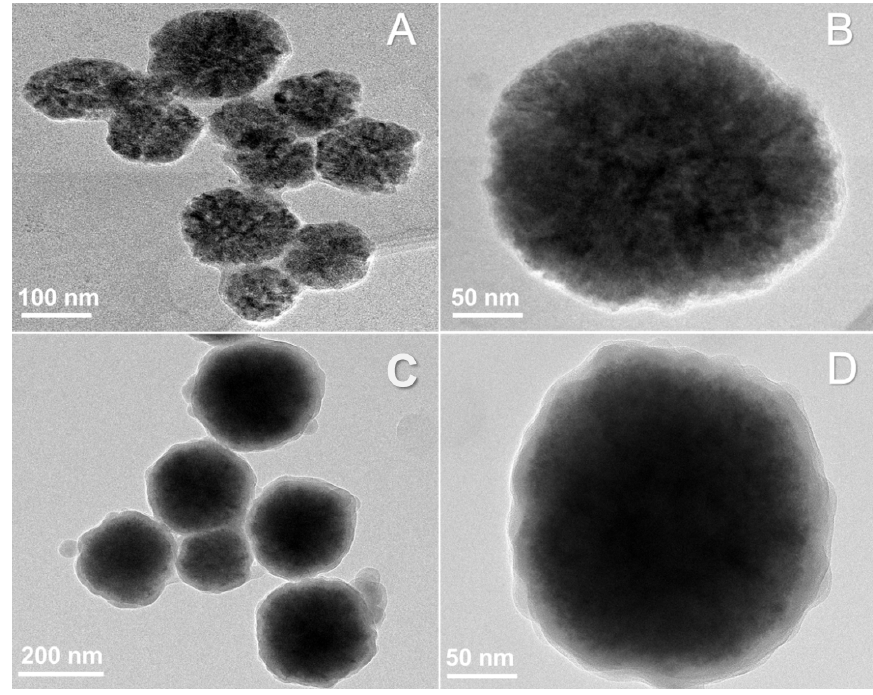
Figure 2. HR-TEM images of the ( A , B ) Fe 2 O 3 nanosphere and ( C , D ) BSiO 2 -Fe 2 O 3 particles. The synthesis of Ag NPs was confirmed using UV-visible spectroscopy (Figure